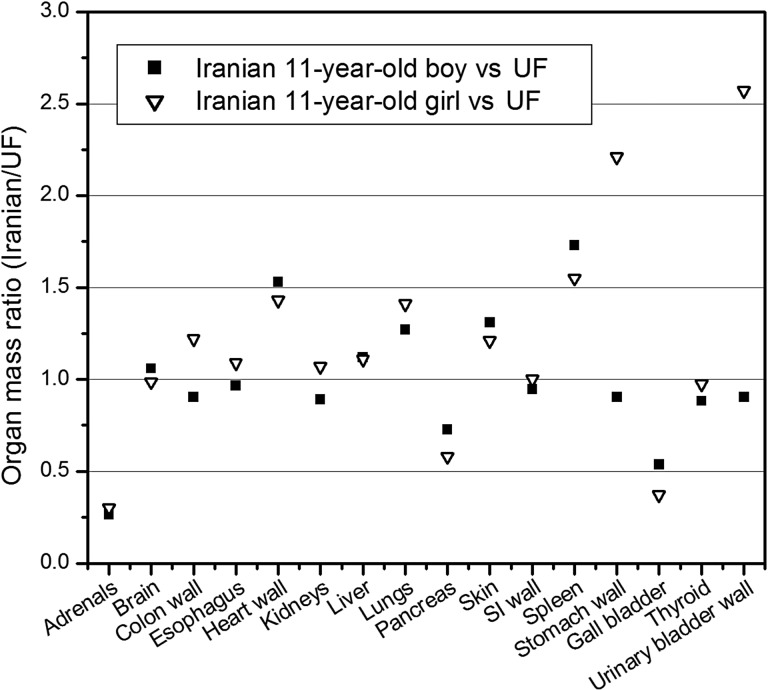
Organ mass ratio of Iranian and UF 11-year-old phantoms.